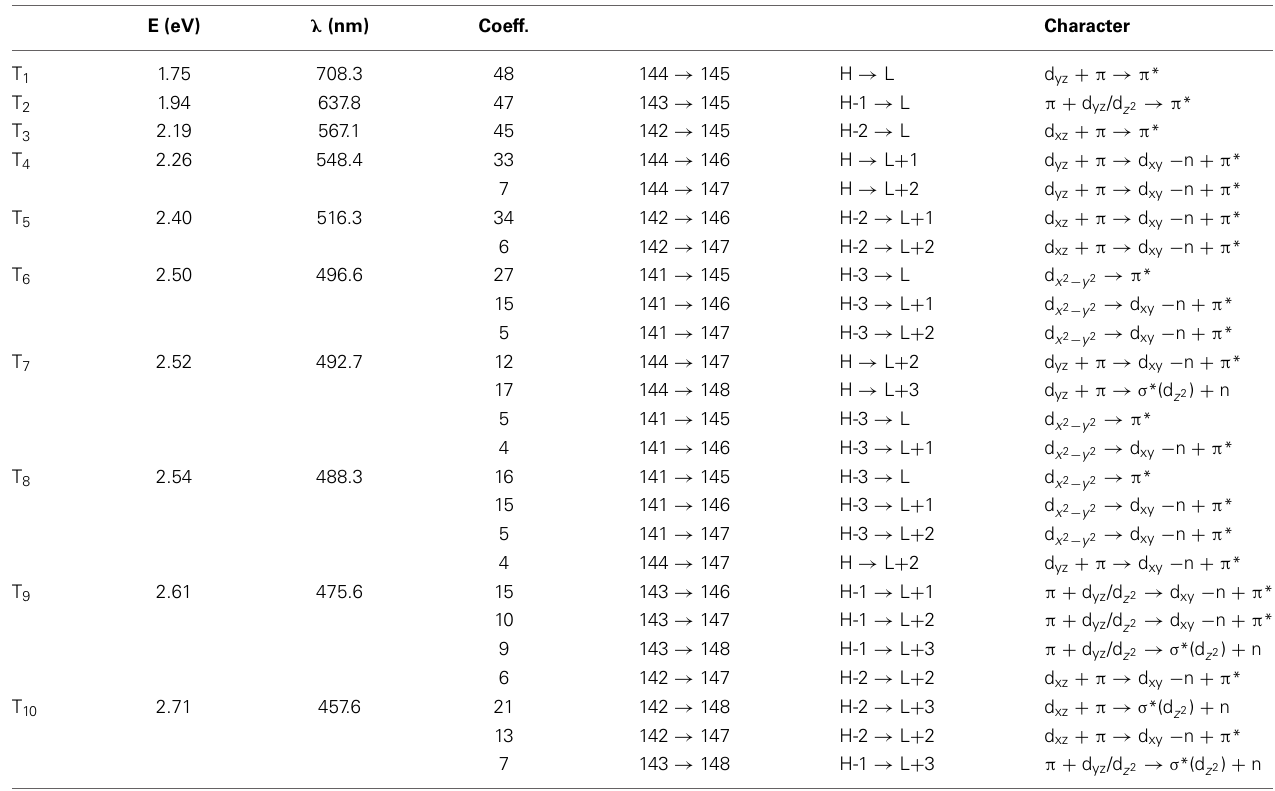
Table 4 | The lowest ten triplet states for RibCbl received from TDDFT/TZVP PCM (water) calculations. E (eV) λ (nm)